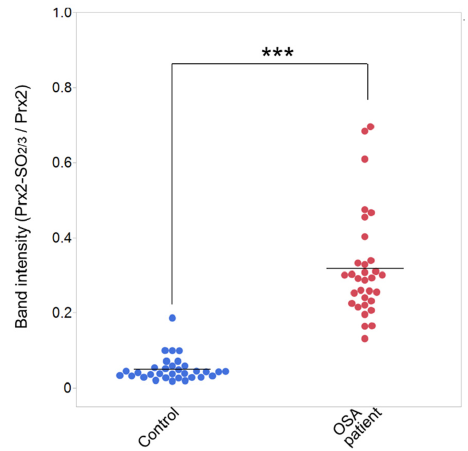
Figure 2. Beeswarm plots for band intensities (Prx2-SO 2/3 /Prx2) of healthy subjects and OSA patients. The densities of Prx2-SO 2/3 bands were measured and normalized to that of Prx2. The band intensity of patients with OSA ( n = 32) and healthy control subjects ( n = 32) was expressed as the normalized ratio of density (Prx2-SO 2/3 /Prx2). *** p < 0.001 versus control group.